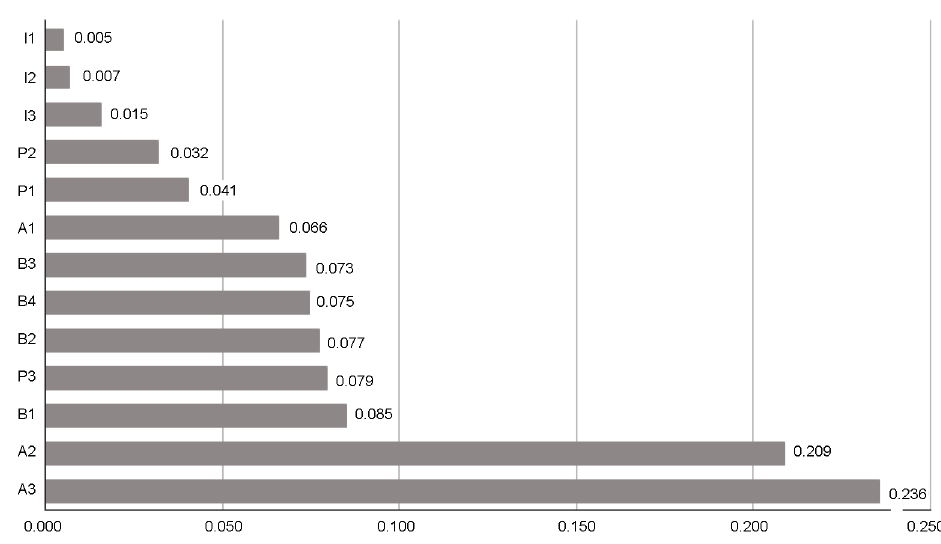
Figure 4. Priority of the factors influencing the development of trust for owners